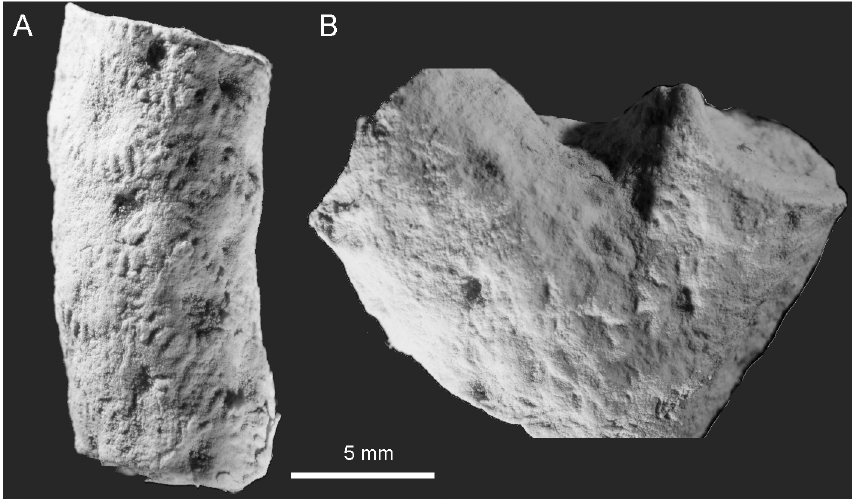
Fig 8. Thamnoptychia mistiaeni sp. nov. from Kowala Quarry, lithological sets J or K, Upper Famennian. (A) External view of a branch. Specimen GIUS 3619 KF 090c. (B) External view of a branch. Specimen GIUS 3619 KF